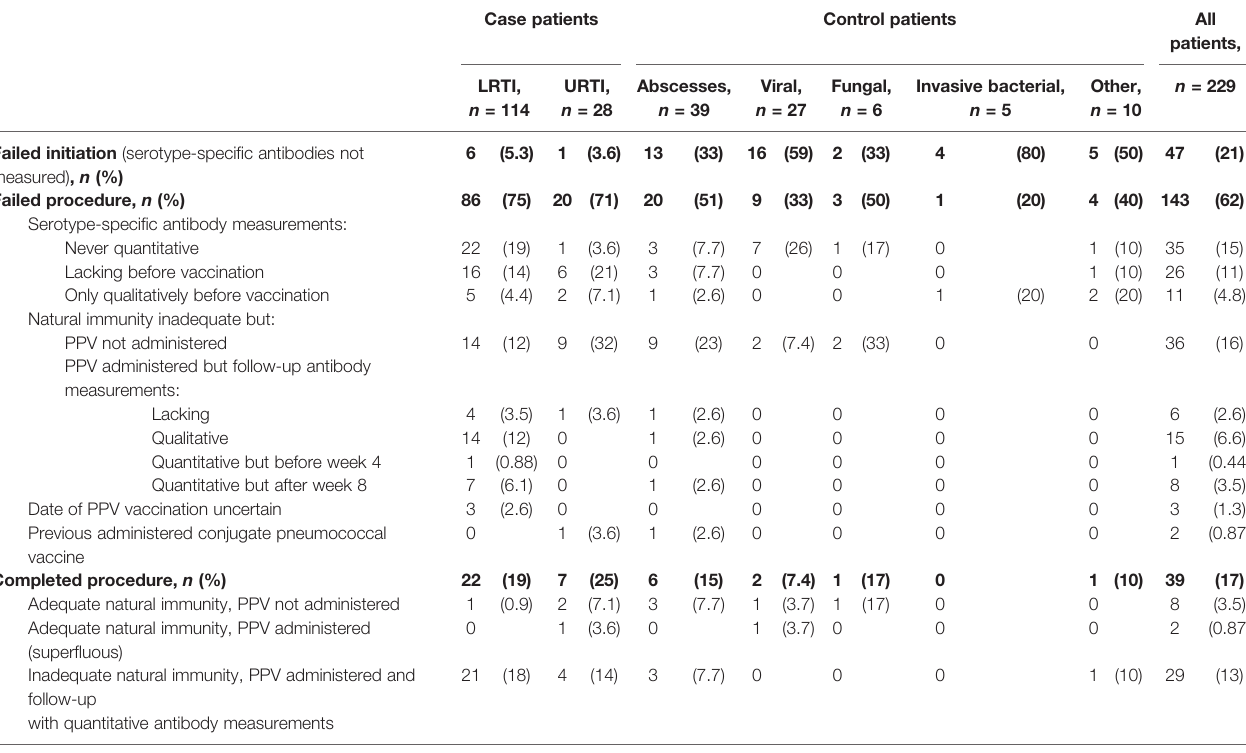
Each participant was assigned to the fi rst correct category in the left column (top-to-bottom). Adequate natural immunity was de fi ned as ≥ 70% of measured levels of serotype-speci fi c antibodies ≥ 1.3 mg/L. Categories of compliance are indicated in